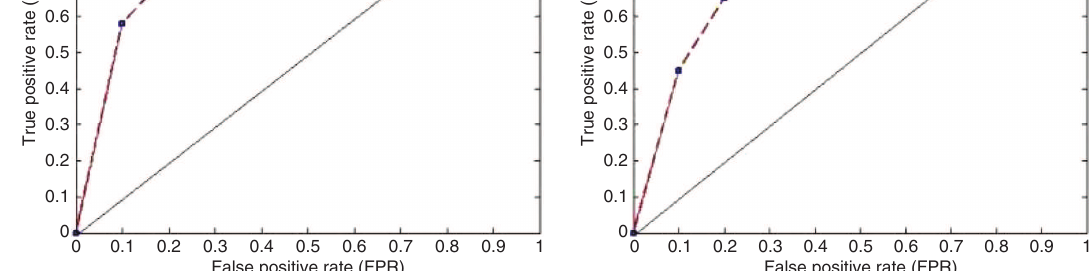
Figure 2: ROC Plots for “Battery” and “Body”.